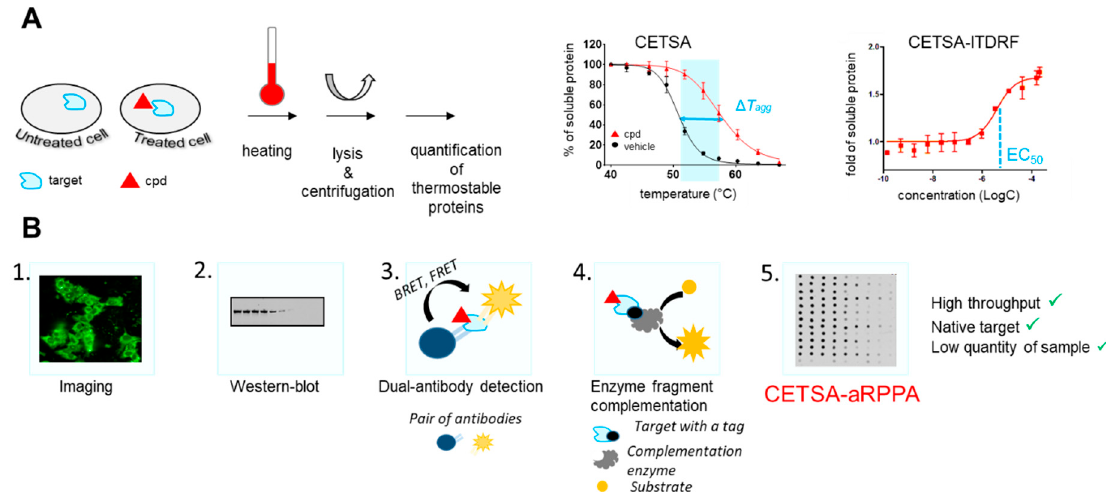
Figure 2. Target engagement using CETSA and CETSA-aRPPA. ( A ) Principle of CETSA and measurement of ∆ Tagg of protein and ITDRF; ( B ) detection methods: 1. Immunofluorescent staining with a target-directed antibody and high-content imaging; 2. Western blot using immunofluorescent staining; 3. Dual-antibody detection of the folded target protein and antibody proximity detection systems based on, for example, Bioluminescence or fluorescence; 4. enzyme fragment complementation (EFC) system where a small fragment tag (e.g., 42 amino acid of β -galactosidase; or 14 amino acid Hibit fragment of nanoluciferase) is tagged to the target of interest, and compound-mediated target stabilization is subsequently detected by the addition of the enzyme acceptor (EA) fragment (e.g., rest of β -galactosidase or NanoLuc) and luminescence reporter; 5. CETSA-aRPPA uses immunostaining detection (dotblot format) and acoustic reverse phase protein array. CETSA-aRPPA combines a high throughput, low quantity of material, and advantageously no need for target tagging, in comparison to other detection methods.